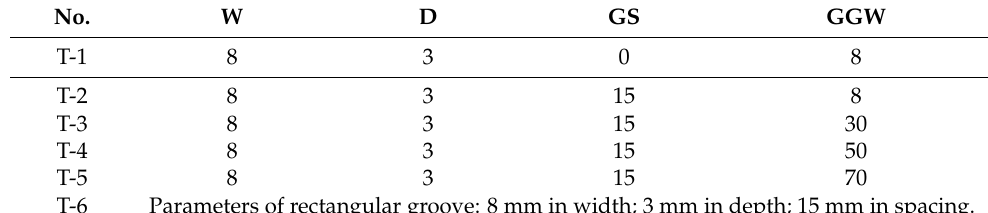
Table 8. Test specimen parameters.